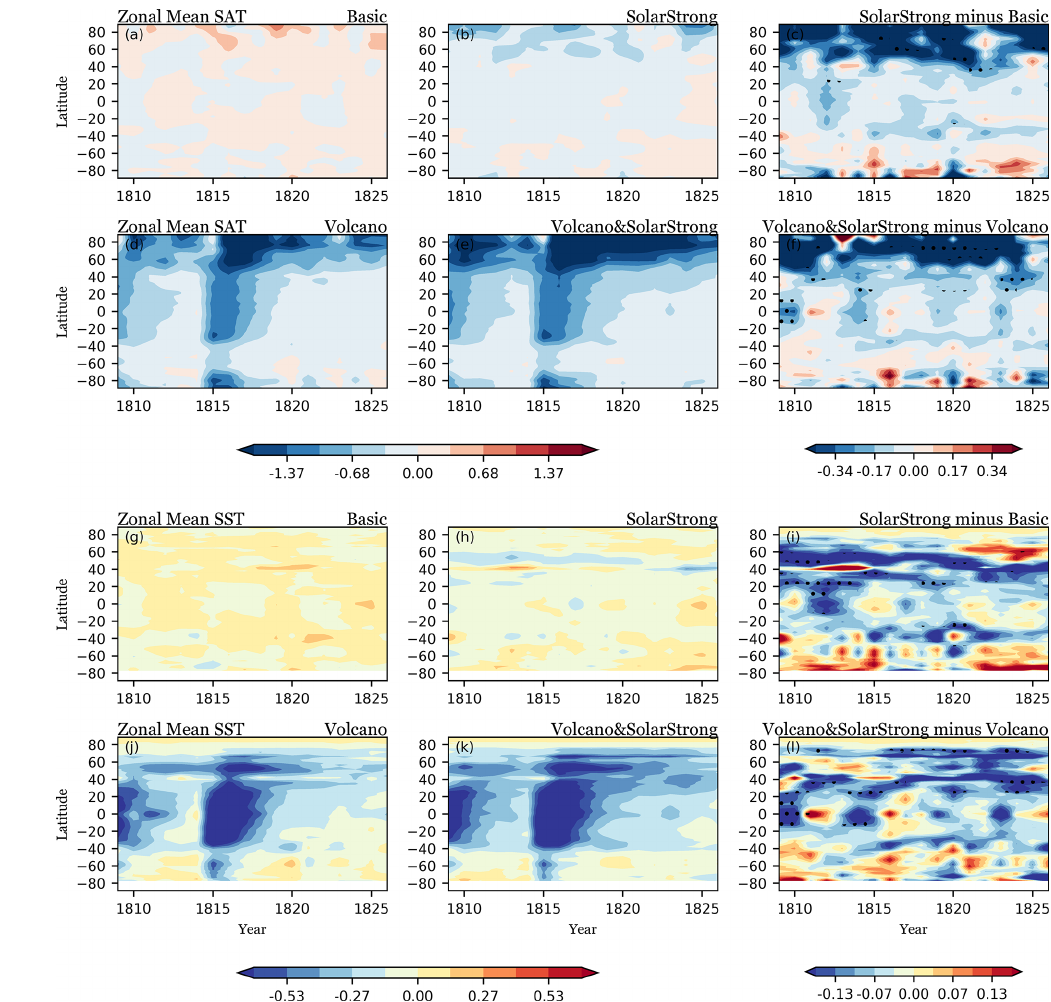
Figure 7. (a) Hovmöller plot for zonal mean winter SAT anomaly (K) for the Basic experiment. (b) The SolarStrong, (c) SolarStrong minus Basic. The black dots illustrate the significance (see Sect. 2 for details). (d) Volcano, (e) Volcano&SolarStrong, and (f) Vol- cano&SolarStrong minus Volcano. (g) – (l) are for SST